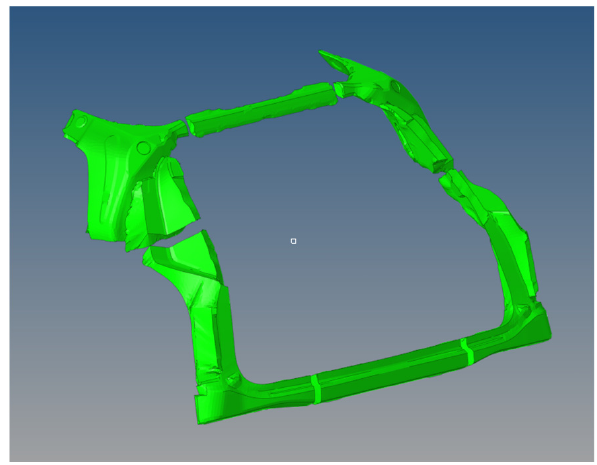
Figure 13. Rear part design space.